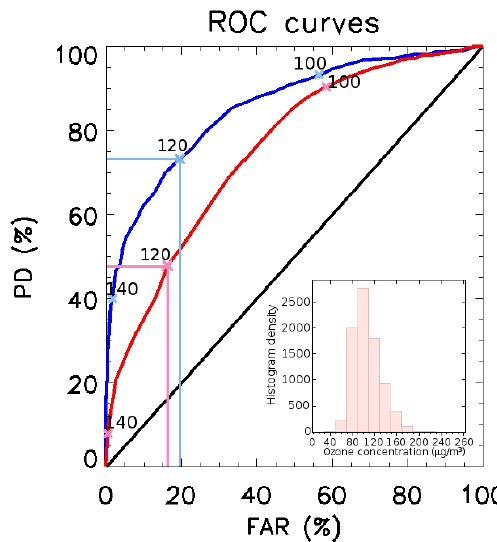
Figure 12. Receiver operating characteristic (ROC) curves, that rep- resent the probability of detection (PD) vs. the false alarm rate (FAR) considering the pixels for daytime (07:00–17:00UTC) over land at the surface. In black is plotted the equal likelihood line, in blue the ROC curve for GEO TIR + VIS and in red the ROC curve for GEO TIR. The ROC curves are calculated for air quality pur- poses, and we highlight the value corresponding to the European threshold (2008/50/CE) for health protection of a surface ozone concentration of 120µg m − 3 , measured for the daily maximum of the 8h running average of the surface values. As a complementary information, two other thresholds (100 and 140µg m − 3 ) are high- lighted. Also the histogram of the distribution of the daily ozone maximum of the 8h running average of the surface values of the reference state is